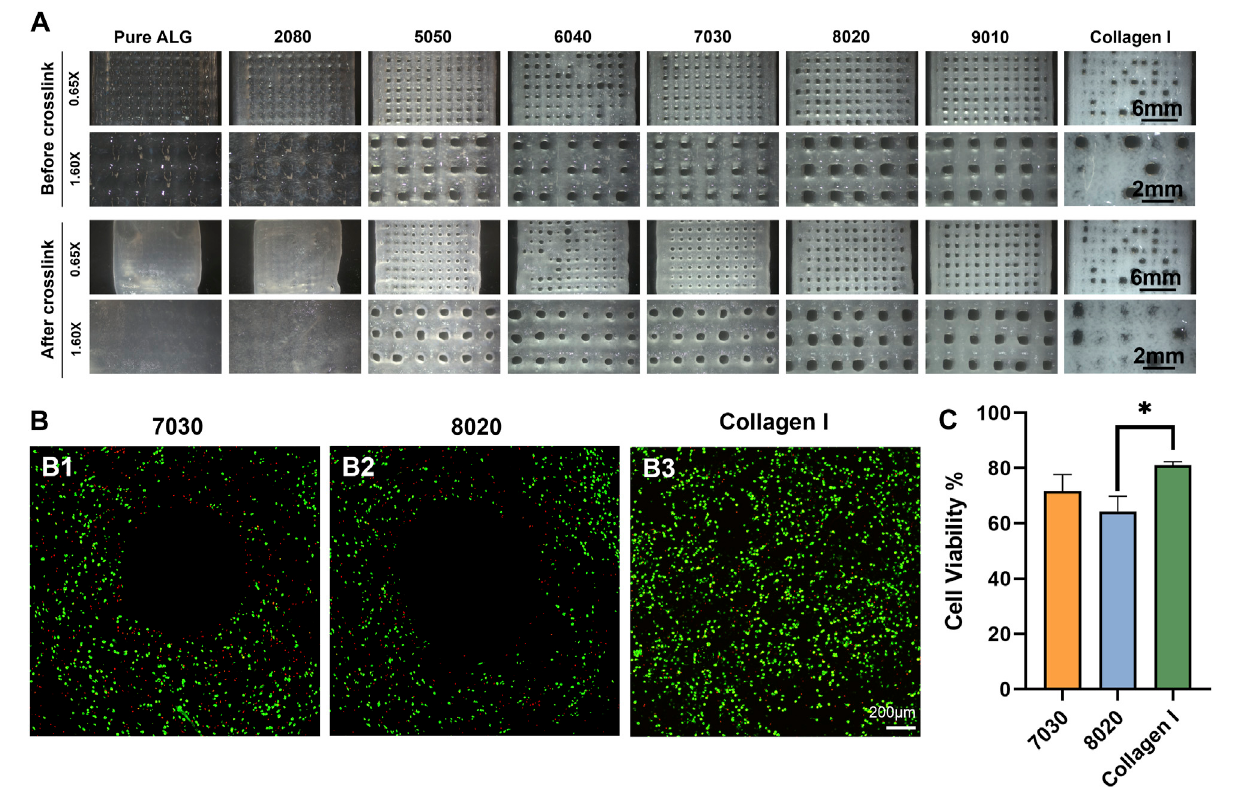
FIGURE 4 | (A) Printed mesh structures using different formulations of TCNF/ALG precursors. (B) Live/dead images of the (B1) 7030, (B2) 8020, and (B3) COL bioinks. Live cells appear green and dead cells red. (C) Quantitative cell viability of the Live/Dead assay images.